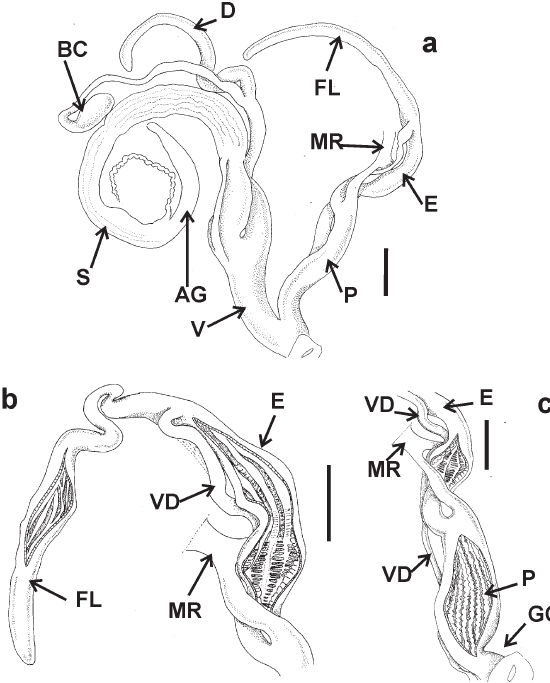
Figure 5 - a-c: a , general view of de reproductive system of